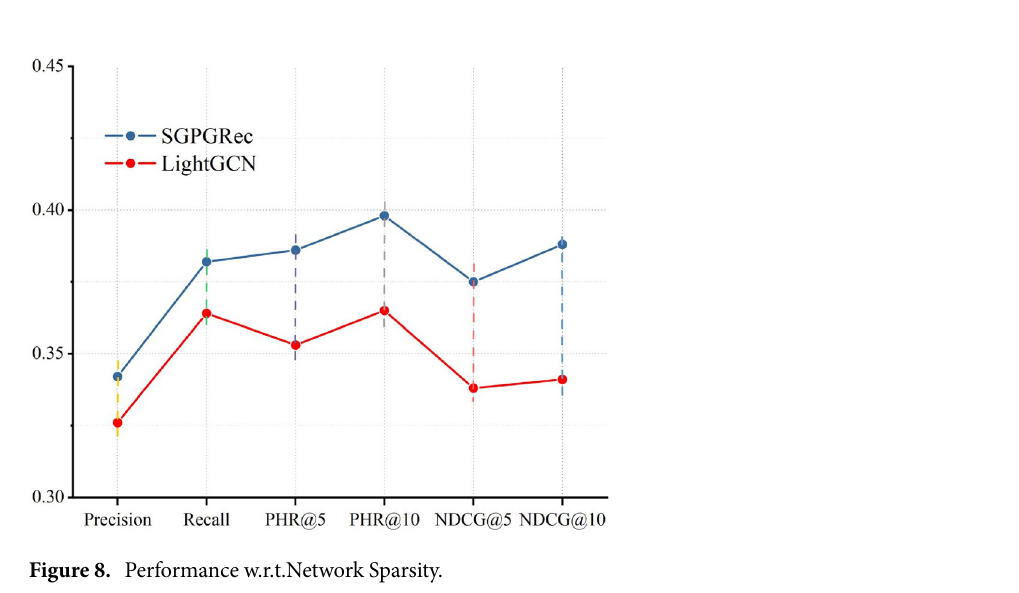
Figure 8. Performance w.r.t.Network